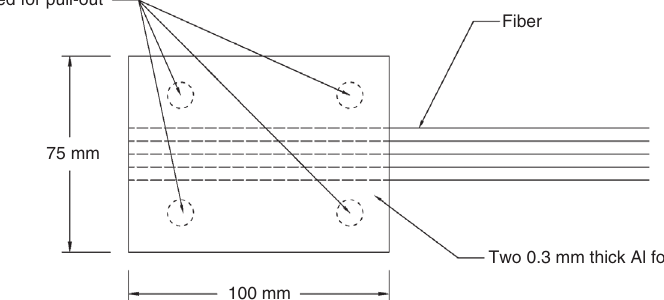
Figure 5 Pull-out test